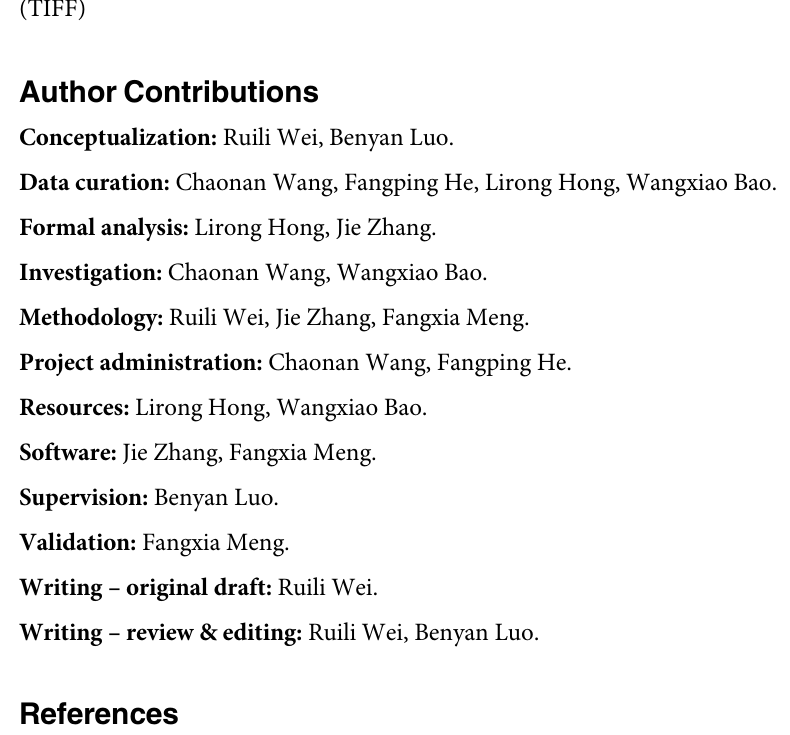
S1 Fig. Risk of bias and applicability concerns summary. Review authors’ judgements about each domain for each included study. S2 Fig. DEEKS funnel analysis to assess the publication